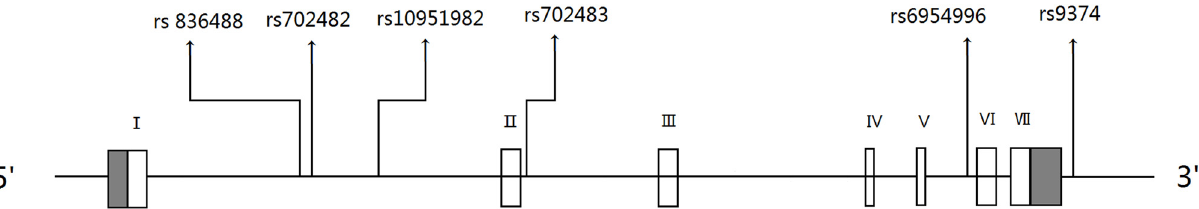
Fig 1. Schematic presentation of the structure of RAC1 gene indicating locations of the analyzed variants (rs836488, rs702482, rs10951982, rs702483, rs6954996, and rs9374). The RAC1 gene consists of 7 exons (I-VII).